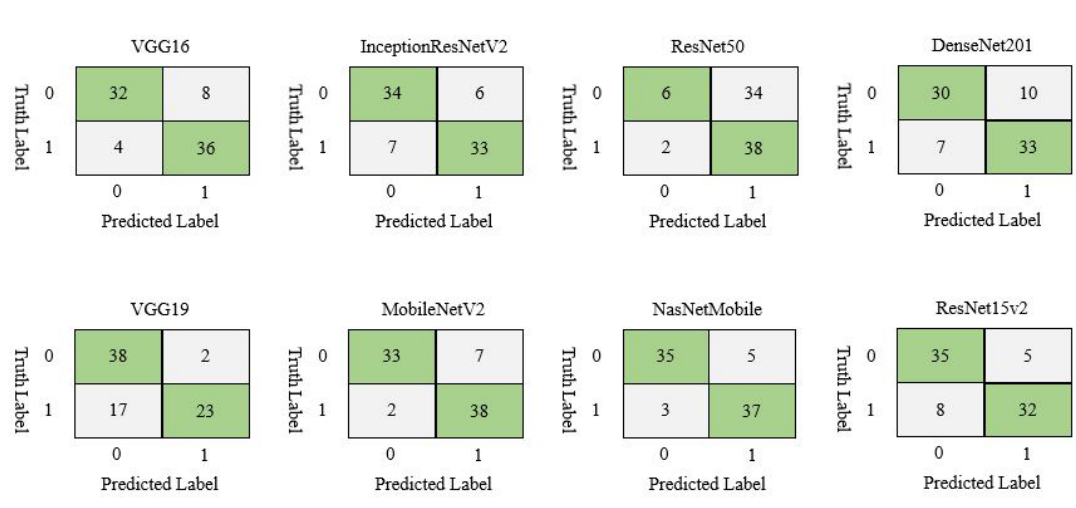
Figure 4. Confusion matrix of different deep learning model for CT scan image